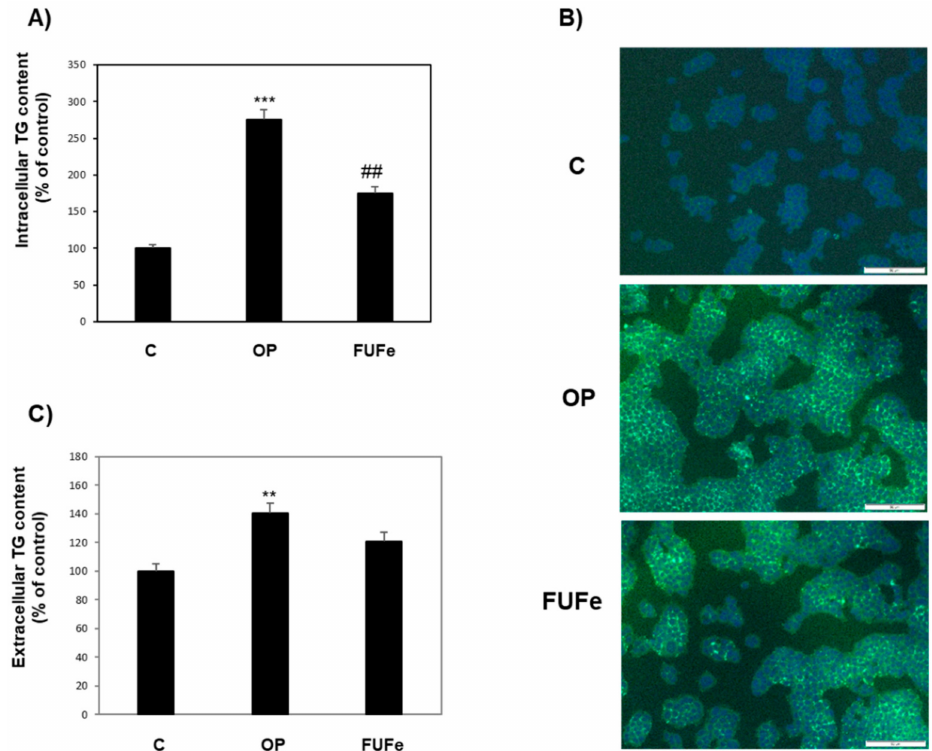
Figure 2. Antisteatotic effect of FUFe on FaO cells. ( A ) Intracellular TG content in control (C) and steatotic cells incubated in the absence (OP) or in the presence of 50 µ g/mL FUFe for 24 h. ( B ) Representative images of BODIPY (green)/DAPI (blue) staining of FaO cells showing cytosolic LDs (Magnification 10 × ; bar 50 µ m). ( C ) Extracellular TG content as measured in the culture medium of the same cells. Data are expressed as percentage of control. Values are mean ± S.D. from three independent experiments. Significant differences are denoted by symbols: ** p ≤ 0.01, *** p ≤ 0.001 vs. C; ## p ≤ 0.01 vs.